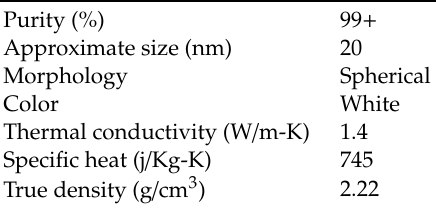
Figure 1. Illustration of SiO 2 –water nanofluid preparation. Table 2. Detailed description SiO 2 nanoparticles (Courtesy: Nanostructured and Amorphous Materials, Inc).